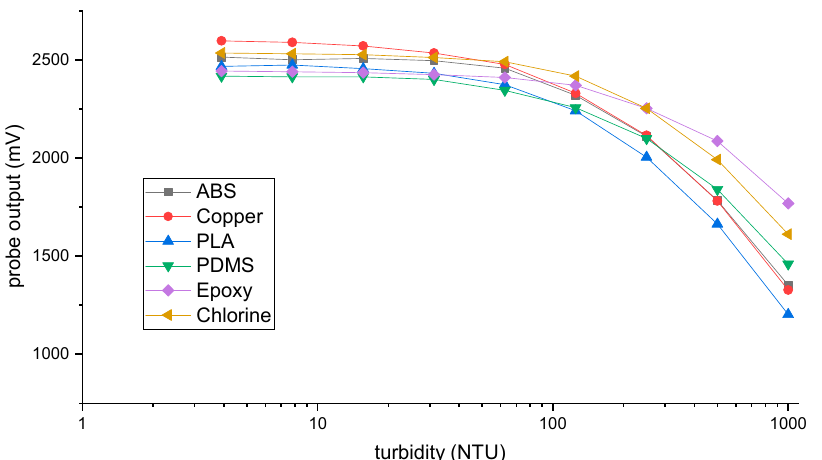
Figure 3. Calibration of the six probes with formazine. The electrical output of each detector is correlated to the different turbidity solutions.